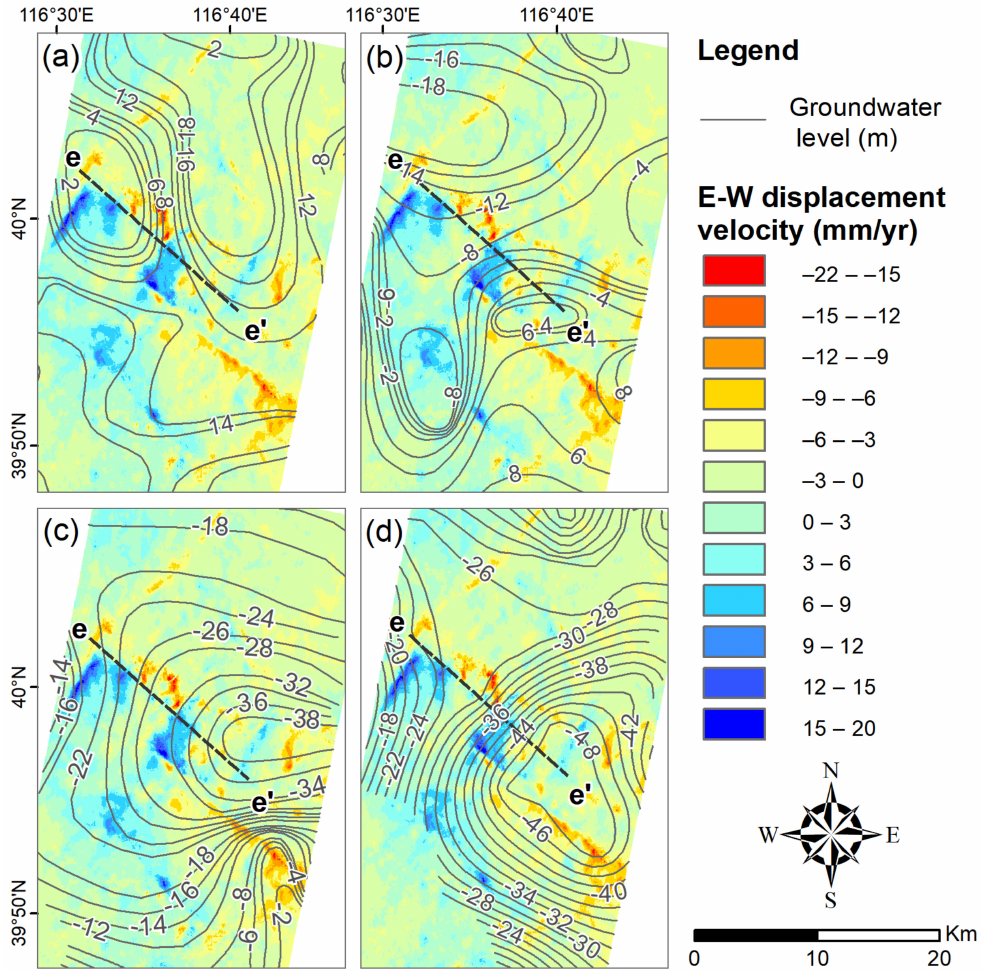
Figure 13. Spatial relationships between the groundwater level and east–west displacement. The contours in ( a – d ) represent the water levels of the unconfined aquifer, the first confined aquifer, the second confined aquifer and the third confined aquifer, respectively. e–e’ is displacement profile within depressions are marked by black dashed